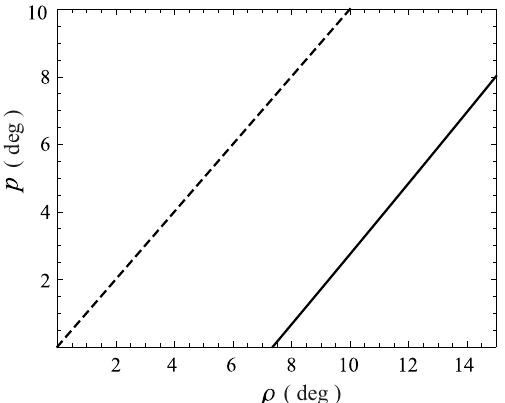
Figure 6. The relation of the angles of the velocity vector and the jet flow local axis to the cone generatrix (solid line), given by Formula (4). The dashed line indicates p = ρ